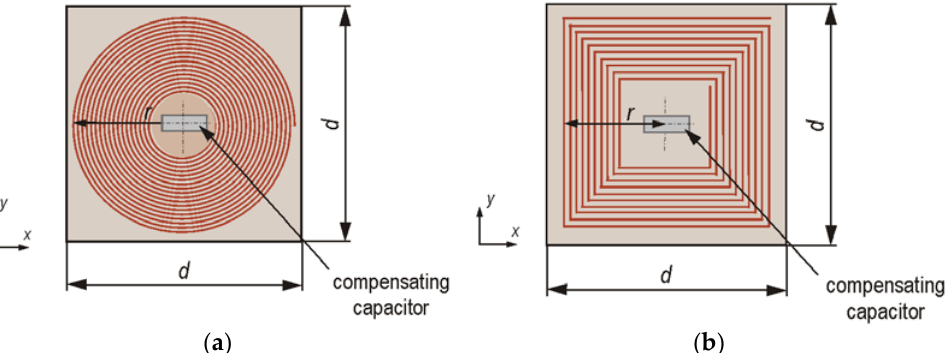
Figure 2. The coils considered in the models: ( a ) circular coil and ( b ) square coil. In the two proposed WPT models, it is possible to select the power conditions in each cell depending on the imposed requirements, e.g., to supply multiple independent receivers simultaneously. The periodic WPT structure consists of two main surfaces: transmitting and receiving, presented in Figure 3. Each surface (composed of Tx or Rx coils) includes a group of planar coils with the same winding direction. The considered cell A x + j , y + k is an element of an array with identical inductors, where j is the number of column and k is the number of row in a grid ( j , k ∈ N and N is the group of integers). Adjacent coils of the element A x , y (e.g., A x +1, y or A x+ 1, y +1 ) are separated by the distance d where d ≈ 2 r .